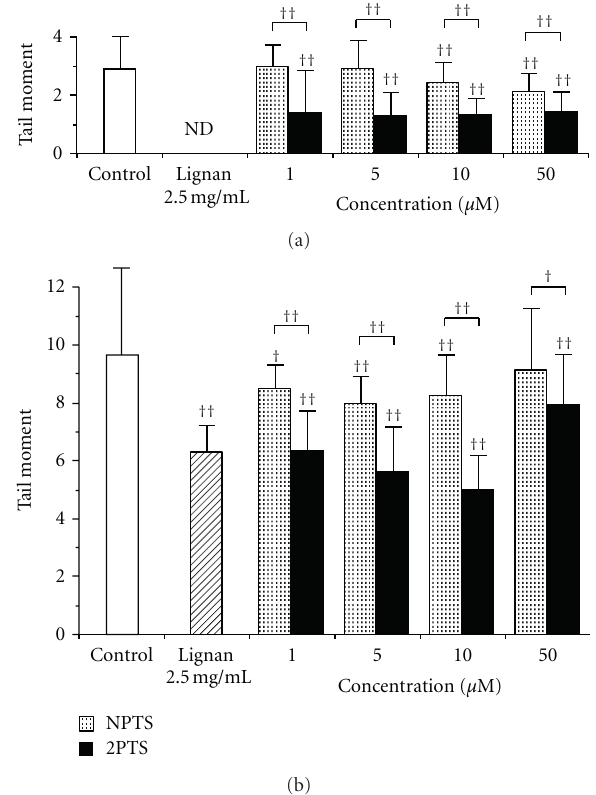
Figure 3: The e ff ect of alk(en)yl thiosulfates on X-ray-induced DNA damage in mouse lymphoma L5178Y cells. Cells were pretreated with di ff erent concentrations (1–50 µ M) of sodium n - propyl thiosulfate (NPTS), sodium 2-propenyl thiosulfate (2PTS), or 2.5mg/mL lignan-containing flaxseed extract for 48 hours at 37 ◦ C before the X-ray irradiation (10Gy). Control cells (white column) were not exposed to any compound. The experiments were divided into nonirradiated (a) and X-ray-irradiated (b) groups. The assessment of DNA damage was carried out on 50–100 individual cells per treatment using a comet assay. Data were analyzed by a one-way factorial analysis of variance with post hoc tests (Tukey’s method). † P < 0 . 005 and †† P < 0 . 001 versus control or between groups. ND: not